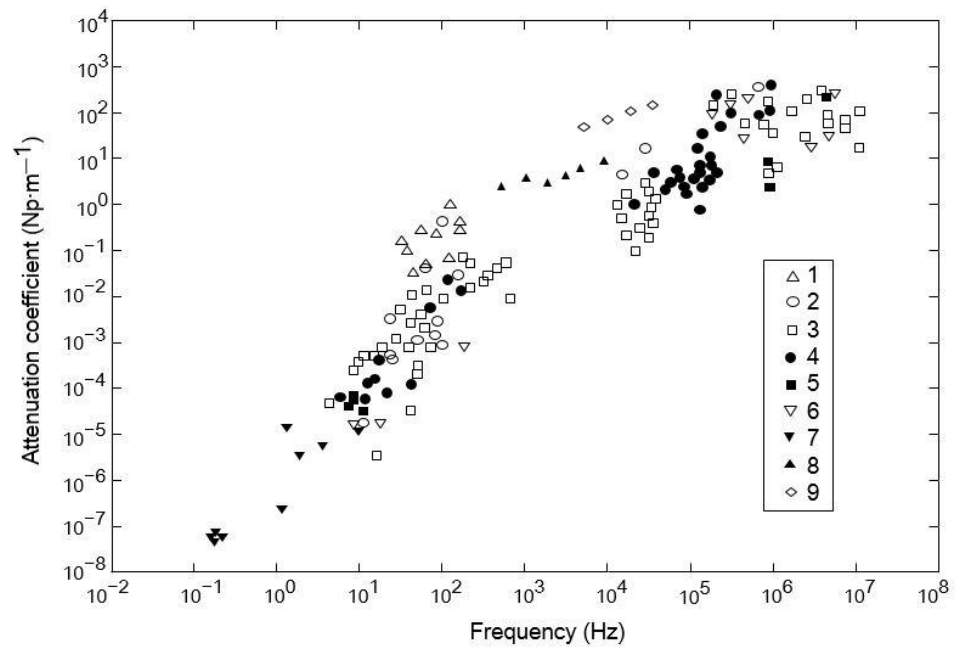
Figure 1. Relationship between the attenuation coefficients of various rocks and frequency: 1 — uncemented sedimentary rock; 2 — semi-cemented sedimentary rock; 3 — solidified sedimentary rock; 4,5 — magmatic rock; 6: metamorphic rock; 7 — results of deep seismic reflections; 8 — limestone; 9 — sandstone (dry).